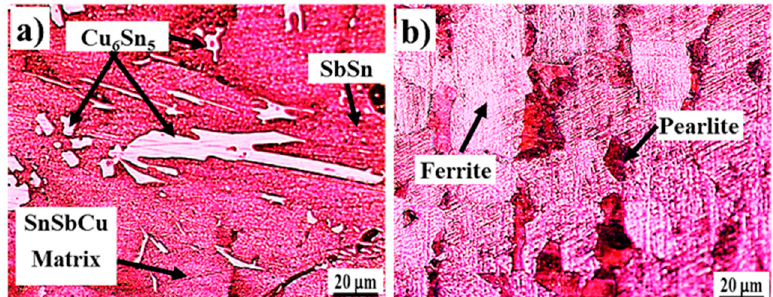
Figure 3. Microstructures of ( a ) tin-based Babbitt alloy, and ( b ) steel substrate, used for preparing bimetallic casting.